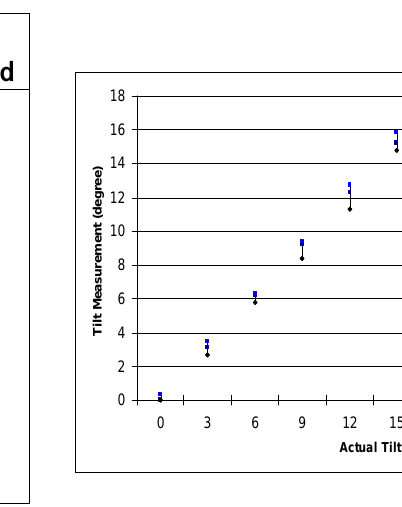
Figure 9. Tabulated results comparing the measured and actual tilt values in degrees for X-axis. Graphical representation of the points is also